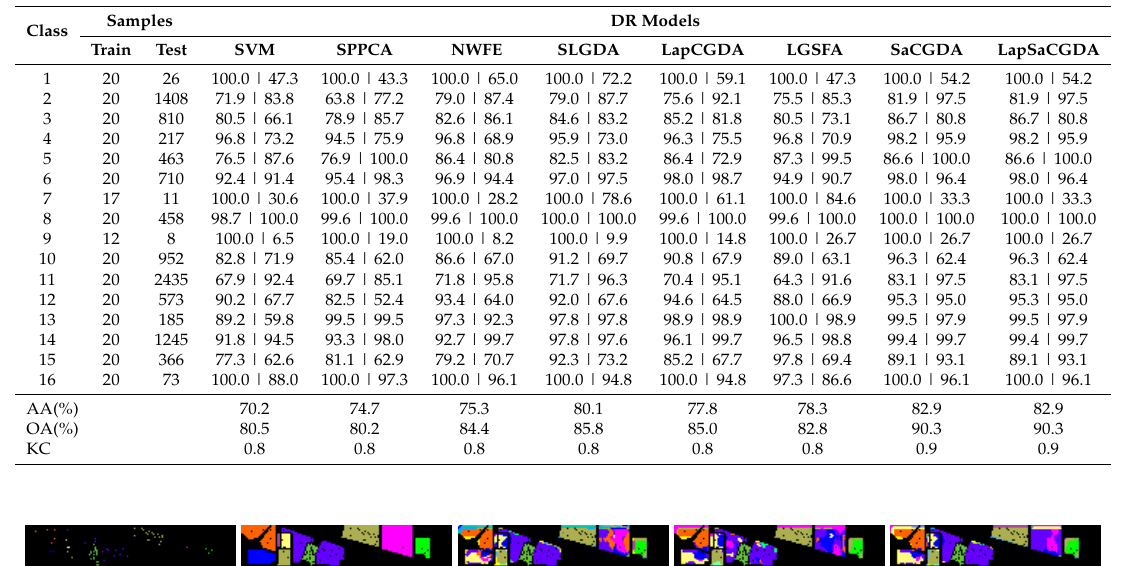
Table 9. Classification results of different DR methods based on SVM on the Indian pines data (the TPR and FPR of each class are displayed in the left and right sides of the vertical line, respectively).